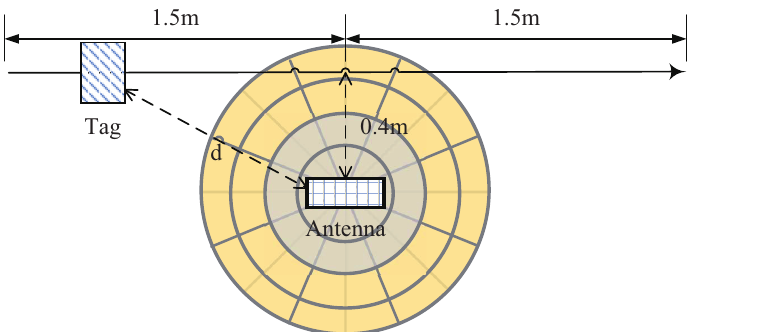
Figure 2. The changes of tag-to-reader distance when a tag moves linearly (omnidirectional antenna in this case).